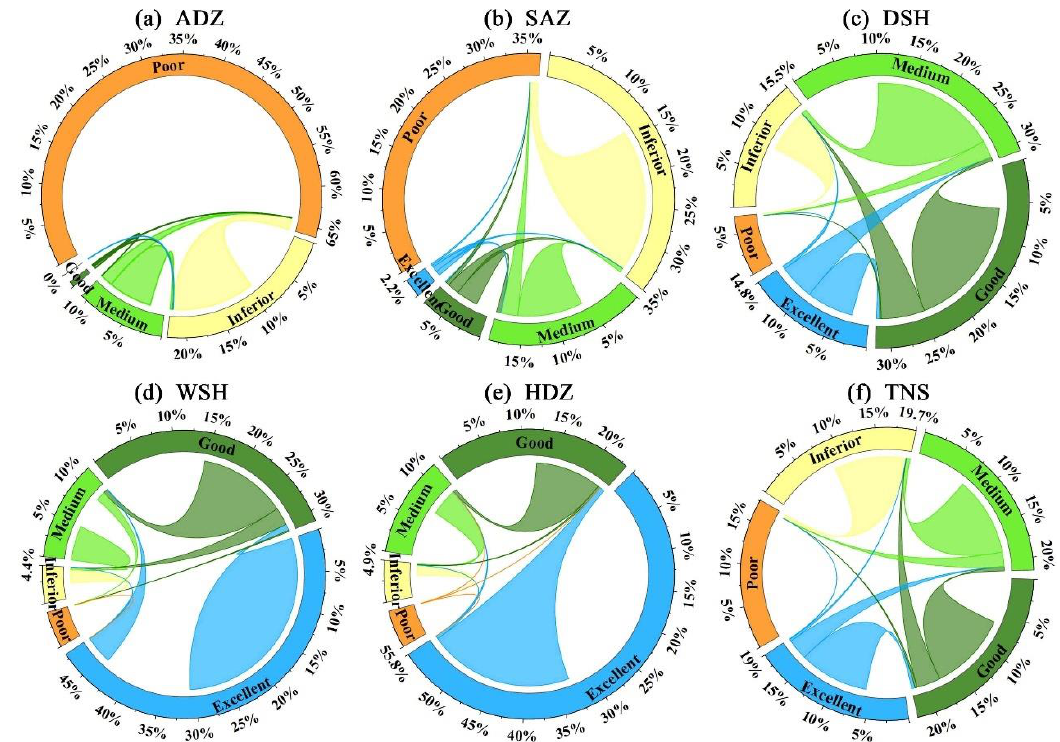
Figure 5. Proportion of transferred area of each type of VEQ in the TNS ( f ) and each climatic zone ( a – e ).